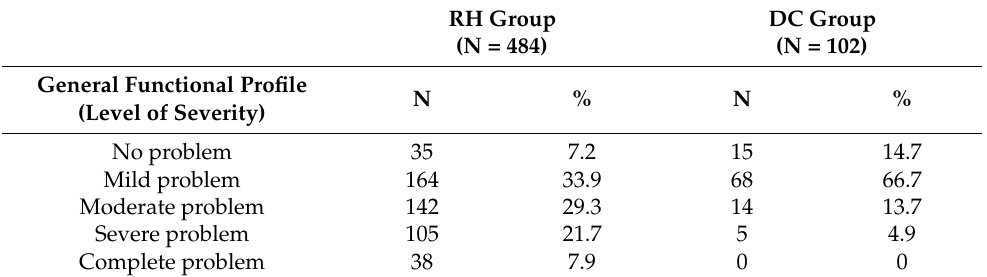
Table 2. Functional profile assessed through the Elderly Nursing Core Set (N = 586).